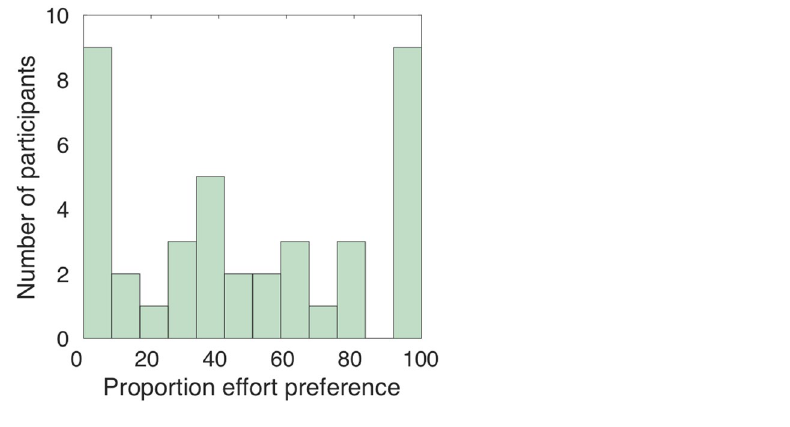
Figure 2. General preference. Depicted is the percentage of trials across the experiment in which a participant chose to first see the effort information of the work offer on that trial. The histogram illustrates variability in choosing effort or reward information first, both across and within participants.